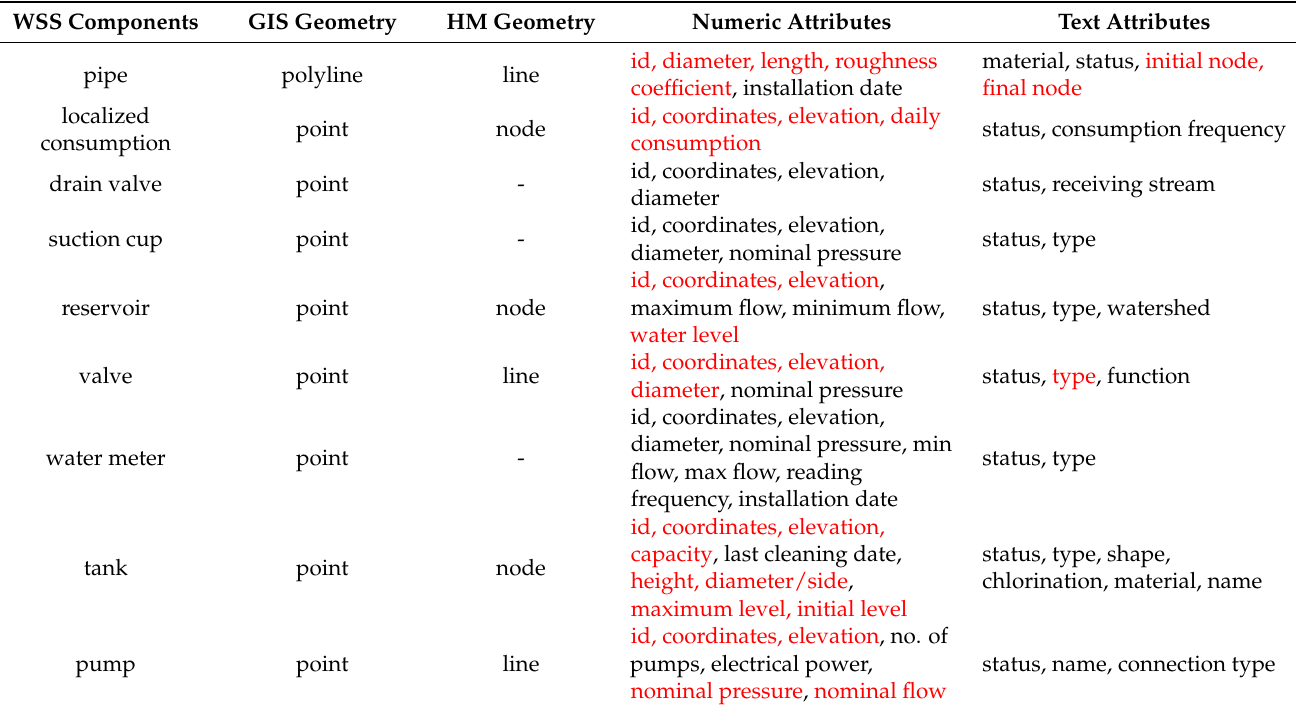
Table 1. Data model. Water supply system geospatial